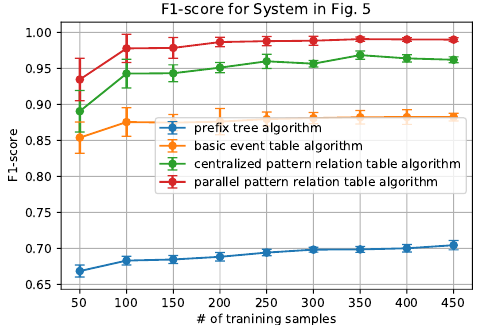
Figure 9. F-1 score for System in Figure